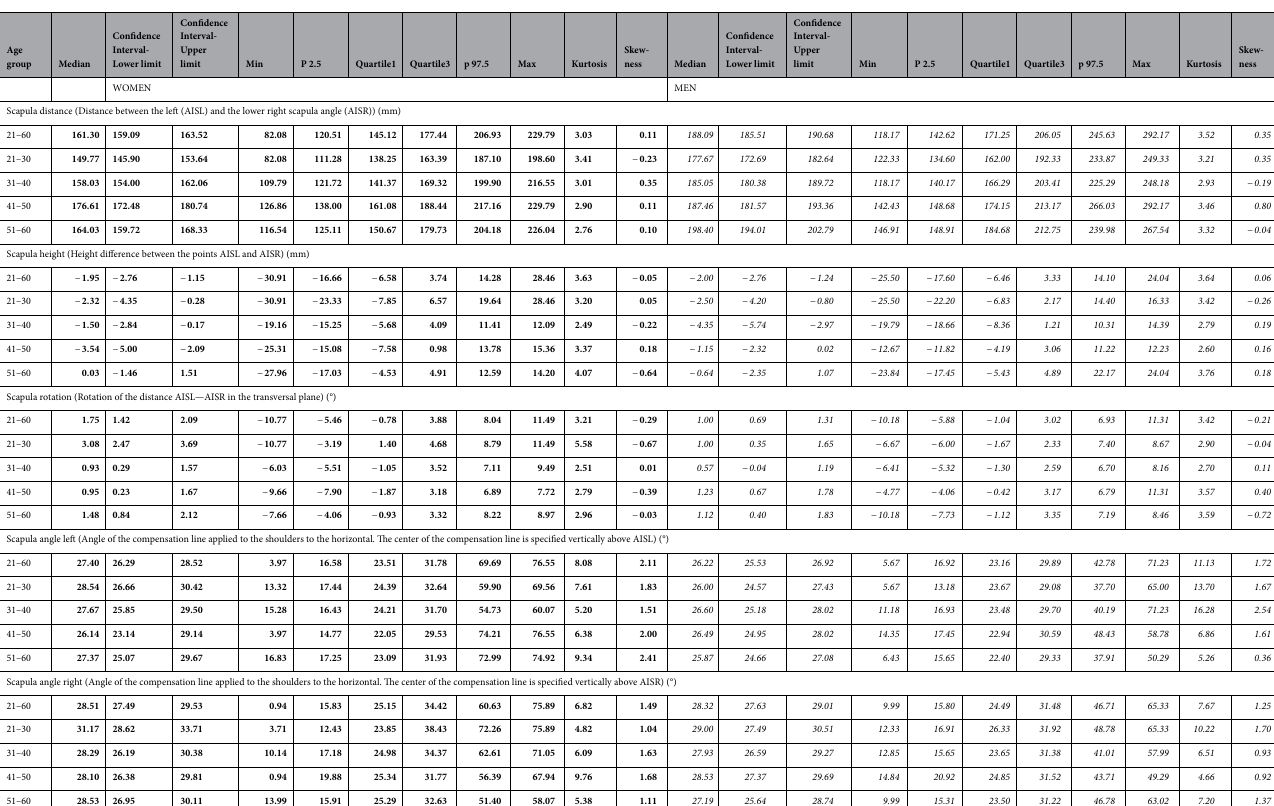
Table 3. Median, confidence interval (lower/upper limit), minimum (Min), percentile (P) 2.5, quartiles 1 and 3, percentile 97.5, maximum (Max), kurtosis and skewness of the shoulder parameters. All data are color- coded by sex (women = bold; men = italic). For each sex, four age groups (21–30,31–40, 41–50, 51–60) and all age groups are shown